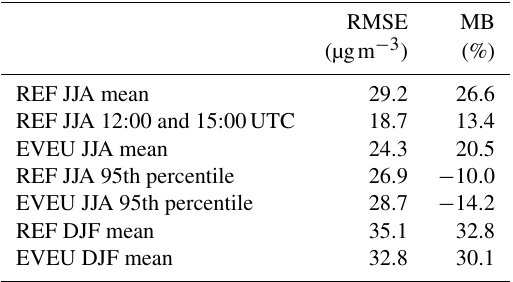
Table 7. Root-mean-square error (RMSE, in µgm − 3 ) and mean bias (MB, in percent) of the REF and EVEU simulations compared to Airbase v8 observation data. Given are the scores for the mean val- ues during JJA and DJF, as well as values for the 95th percentile for JJA. For REF , listed additionally, the scores considering only the values at 12:00 and 15:00UTC are also